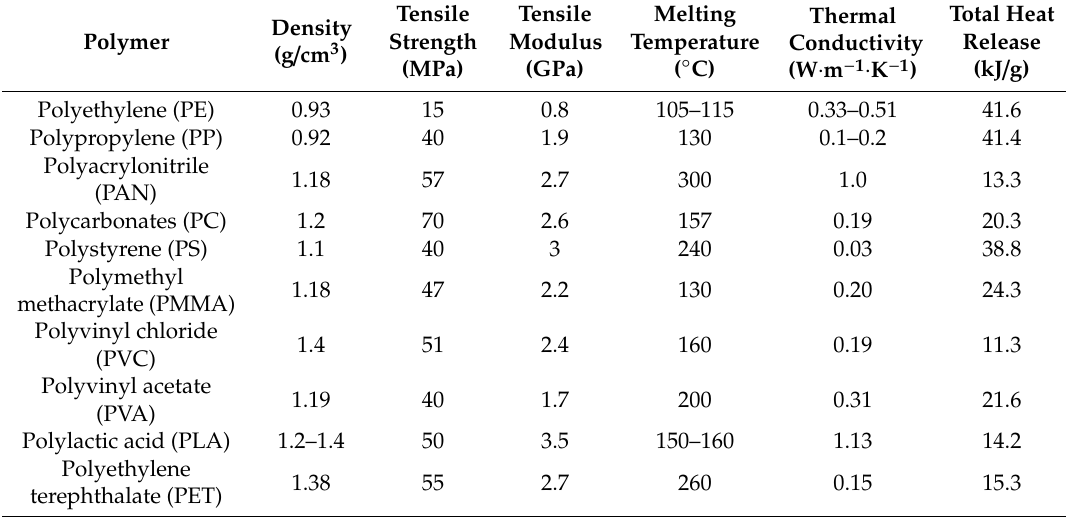
Table 2. Properties of polymer matrices